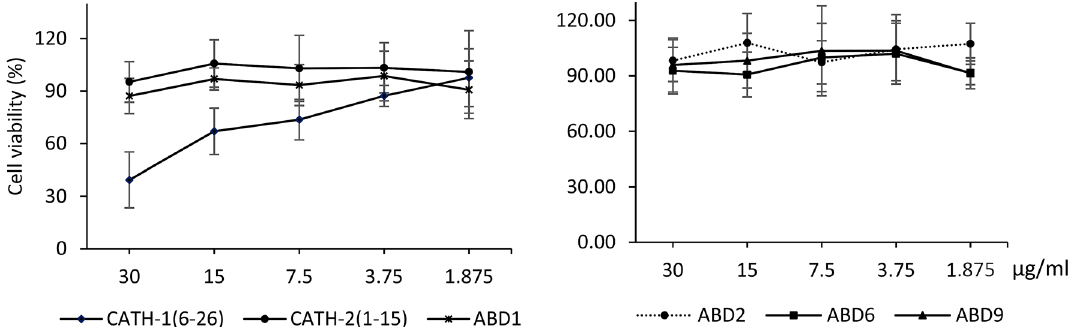
Figure 3. Cytotoxicity of 6 peptides to treated HD11 cells. Cytotoxicity to HD11 cells was determined by WST-1 assay using 1.875–30 µg/ml of each peptide stimulated for 24 h in triplicate. At least three distinct experiments on different days are indicative of the data shown.